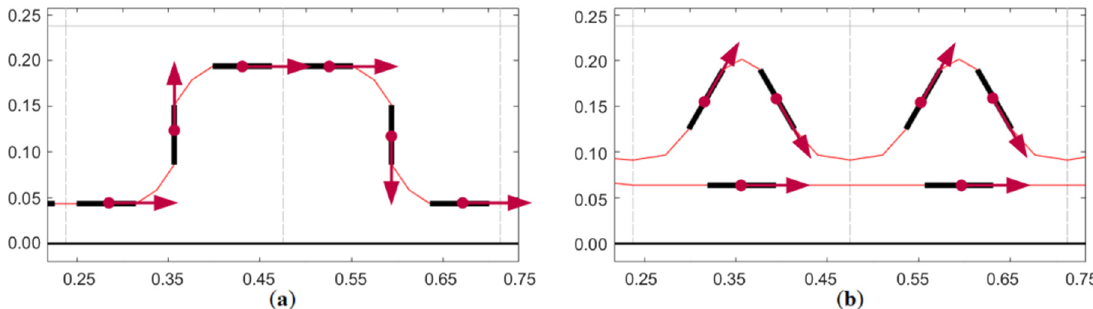
xy strains at the